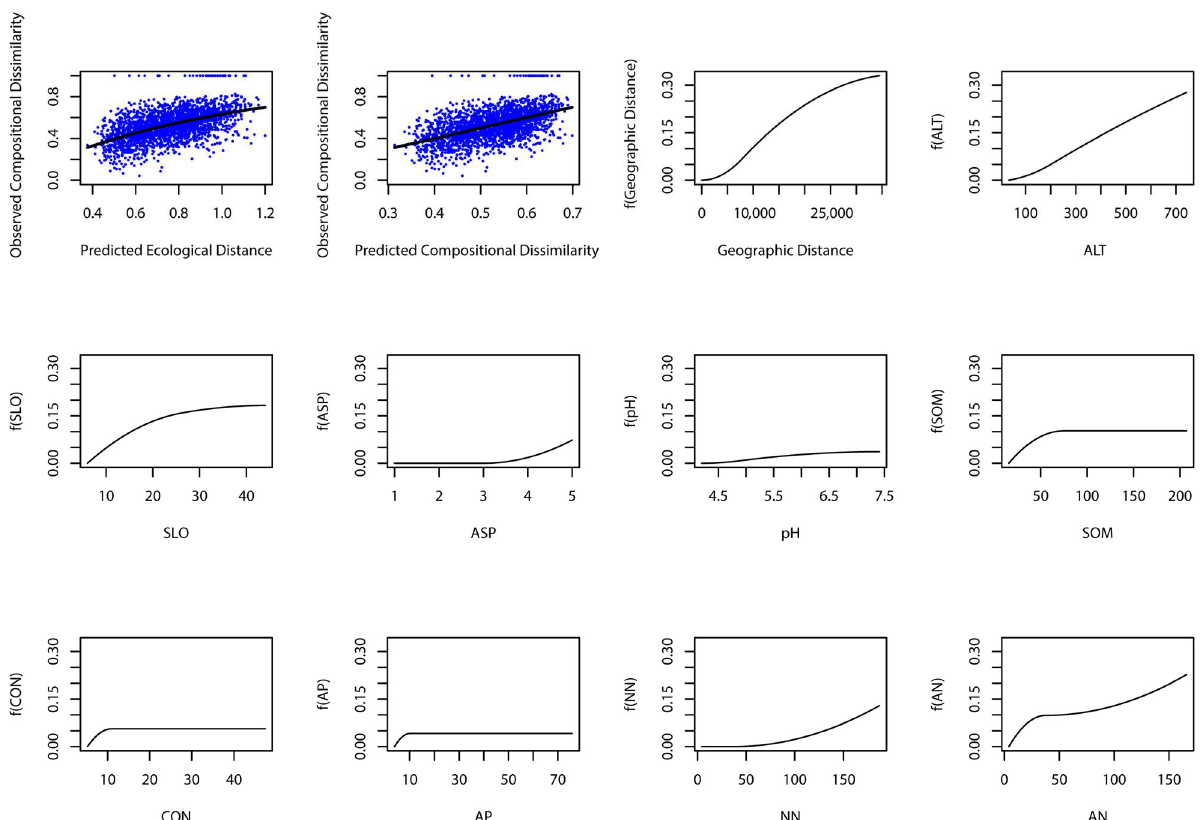
Figure 5. GDM for phylogenetic β sor of saplings in secondary plant communities on Mount Lao. Each blue dot represents a site-pair. ELE: elevation; SLO: slope; POS: position; ASP: aspect; SOM: soil organic matter; CON: conductivity; AP: available phosphorus; NN: nitrate nitrogen; AN: ammonium nitrogen; AK: available potassium.